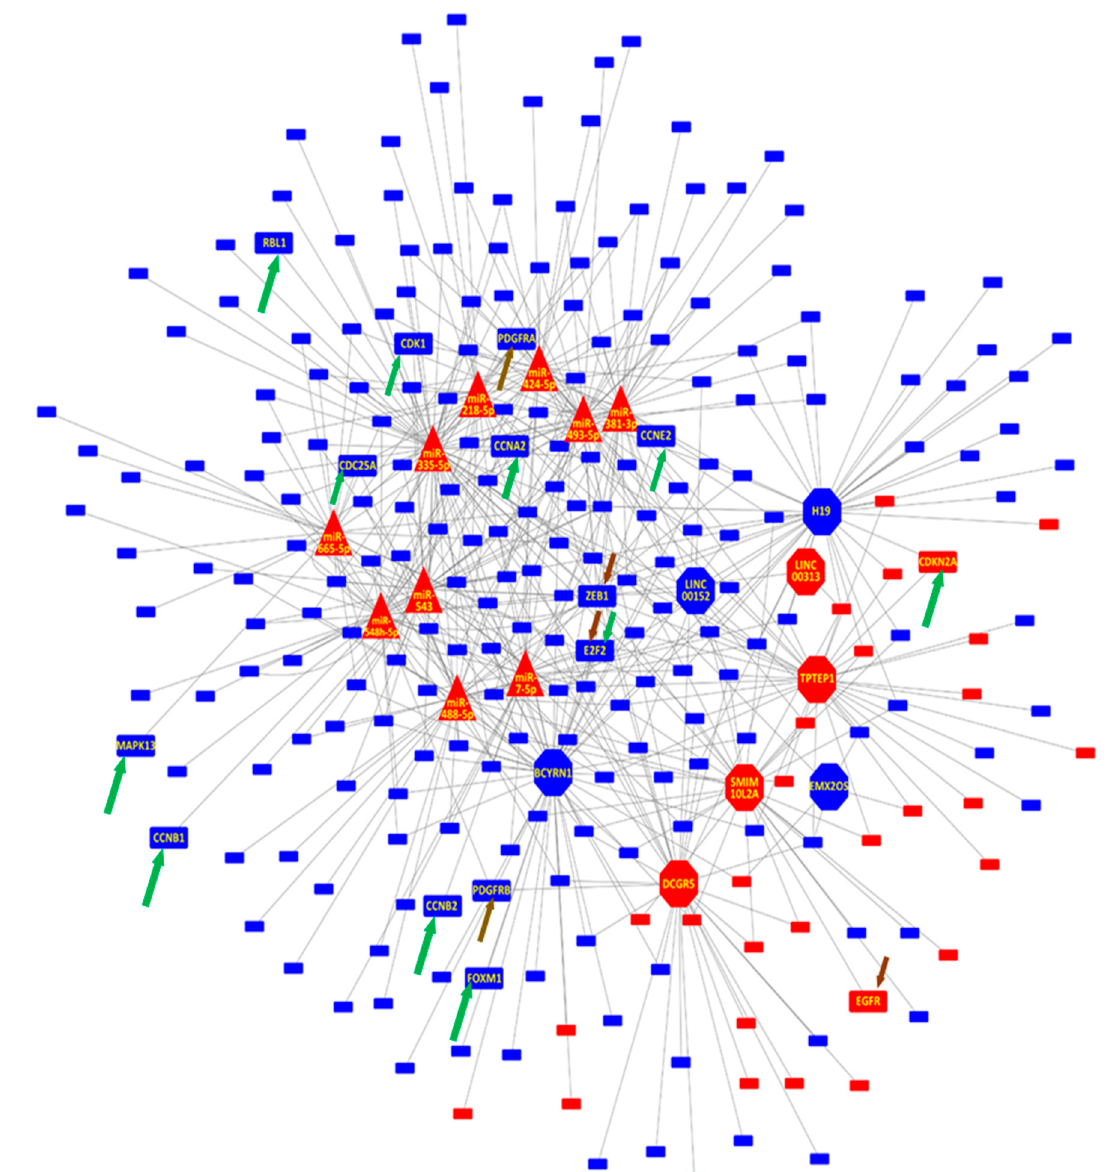
Figure 2. Network representation of lncRNAs and miRNAs gene targets for prostate cell senescence. Only genes related to Cell Cycle and Cell Proliferation are presented. Gene Targets PDGFRB, PDGFRA, CCNE2, E2F2, EGFR, ZEB1 belonging to the Prostate Cancer KEGG pathway are highlighted (gold arrow) as are CCNB1, CCNB2, FOXM1, CCNA2, CDK1, CCNE2, CDC25A, E2F2, CDKN2A, MAPK13, RBL1 (green arrow) from the Cellular Senescence pathway. The lncRNAs MYBL, SERHL and SNHG5 are not depicted as they do not have any gene targets belonging to Cell Cycle and/or Cell Proliferation. Blue indicates down-regulated and red up-regulated in senescent cells relative to non-senescent cells. Genes are presented as rectangles, miRNAs as triangles, and lncRNAs as